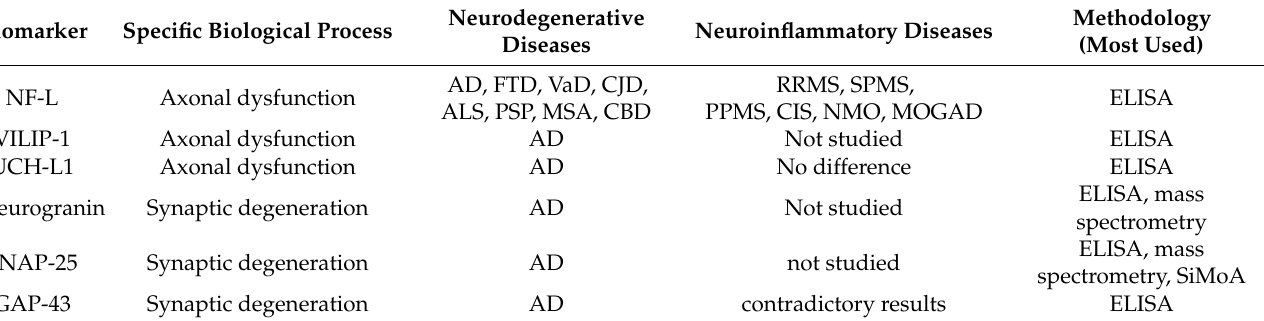
Table 2. CSF-based biomarkers tracking neurodegeneration and synaptic